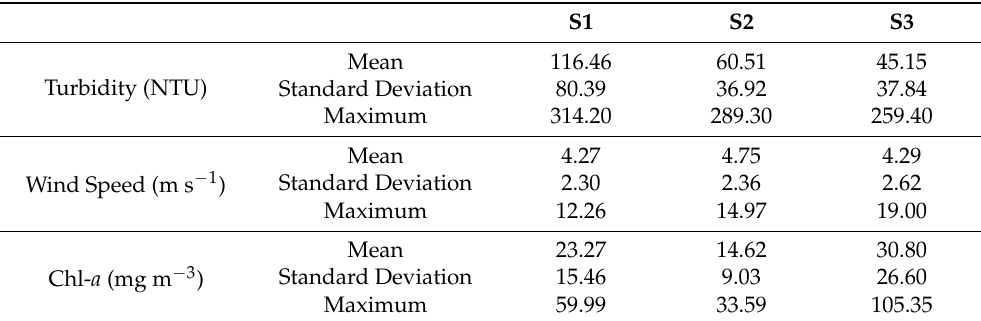
Table 2. Statistical characteristics of turbidity, wind speed, and chlorophyll- a (Chl- a ).